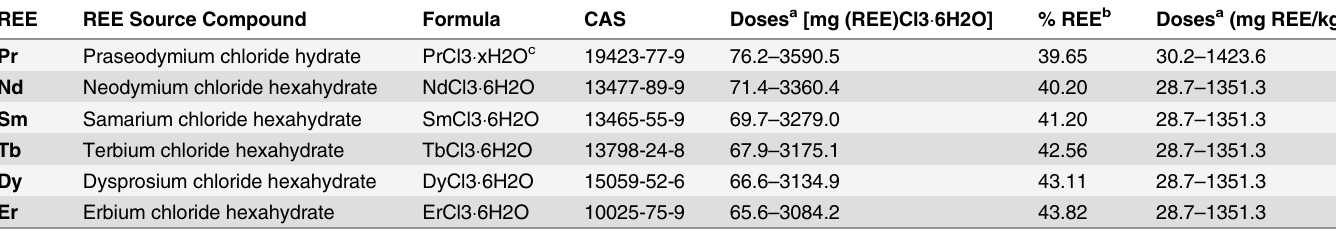
Table 2. Sources of rare earth elements (REEs) and range of doses used for all REE soil exposure